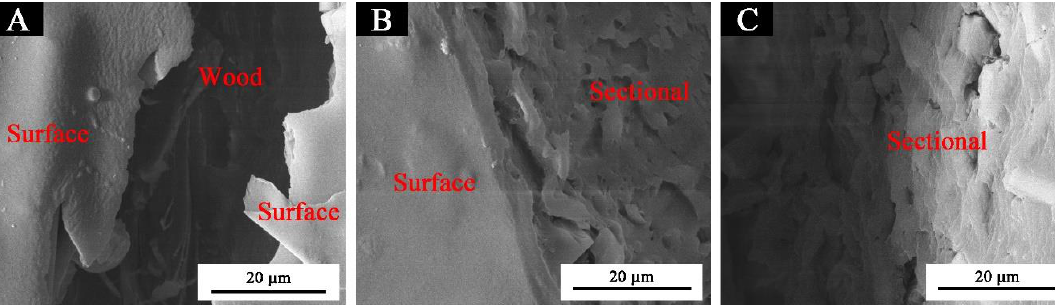
Figure 2. Cross-sectional SEM of the waterborne coatings with thermochromic ink and different concentrations of glass fiber powder: ( A ) pure coating and ( B – D ) 1.0%, 3.0%, and 10.0% glass fiber powder in the waterborne coating with thermochromic ink, respectively.